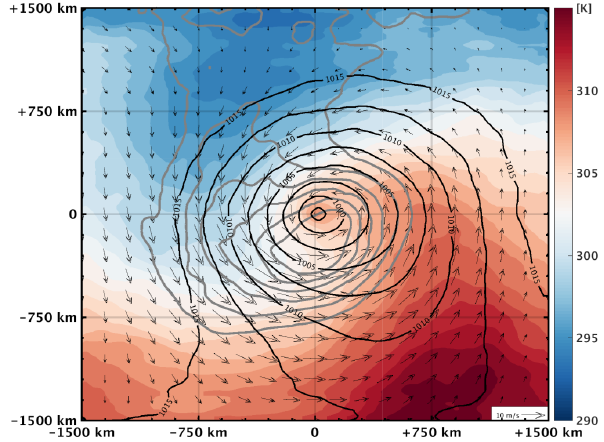
Figure 3. Composite for all 100 cyclones at the time of their ma- ture stage of PV at 300hPa (in grey contours with 0.5PVU con- tour intervals, starting from 1.5PVU), mean sea level pressure (in black contours) and horizontal wind ( arrows ) and equivalent poten- tial temperature at 850hPa (colours) with (0, 0) denoting the posi- tion of cyclone